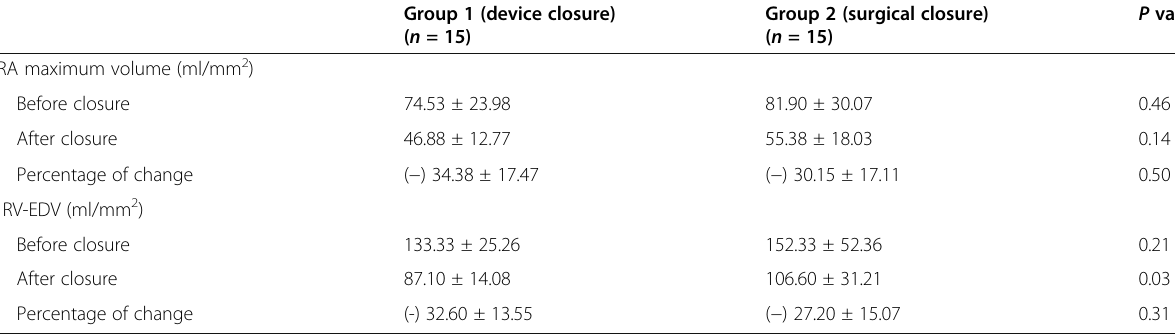
Table 7 Parameters of RA and RV in comparison among two groups